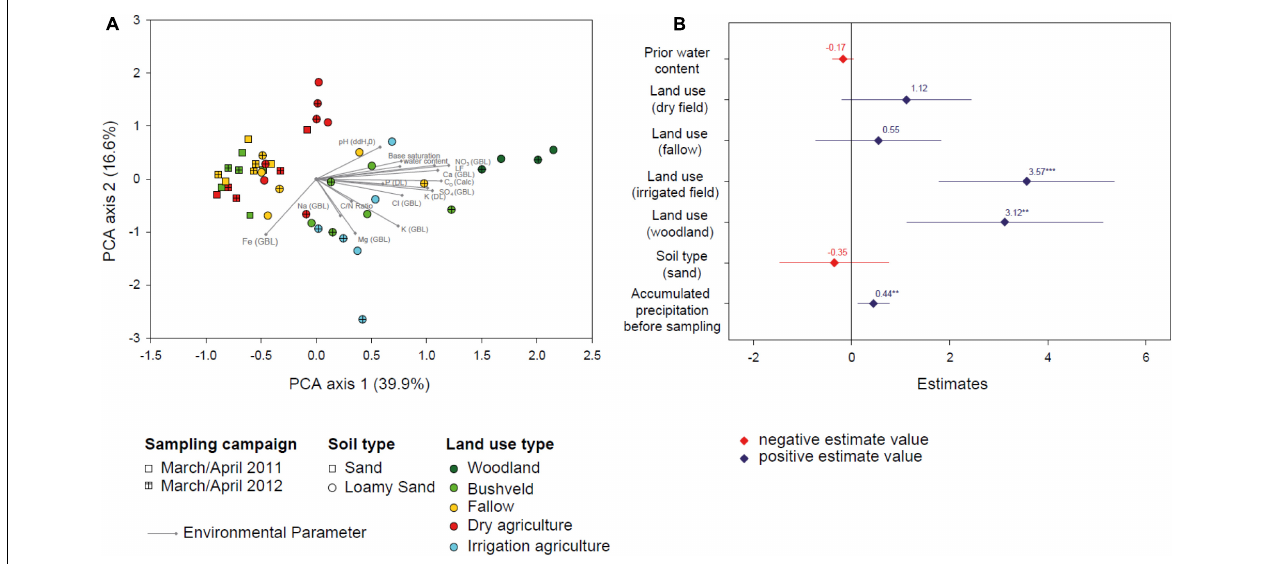
FIGURE 3 | (A) Biplot of a Principal Component Analysis of 14 physicochemical soil variables (specified in the text) for soil samples taken in March/April 2011 and 2012. Symbols give scores for sampling sites and arrows point to the scores of the soil variables. Shape of the symbols indicates soil type and time point of sampling, color indicates land use types. (B) Estimates of a linear model with soil water content as response variable. Diamonds represent values for the estimates and lines represent the 95% confidence intervals. Stars denote estimates that differ significantly from zero (** p < 0.01; *** p <